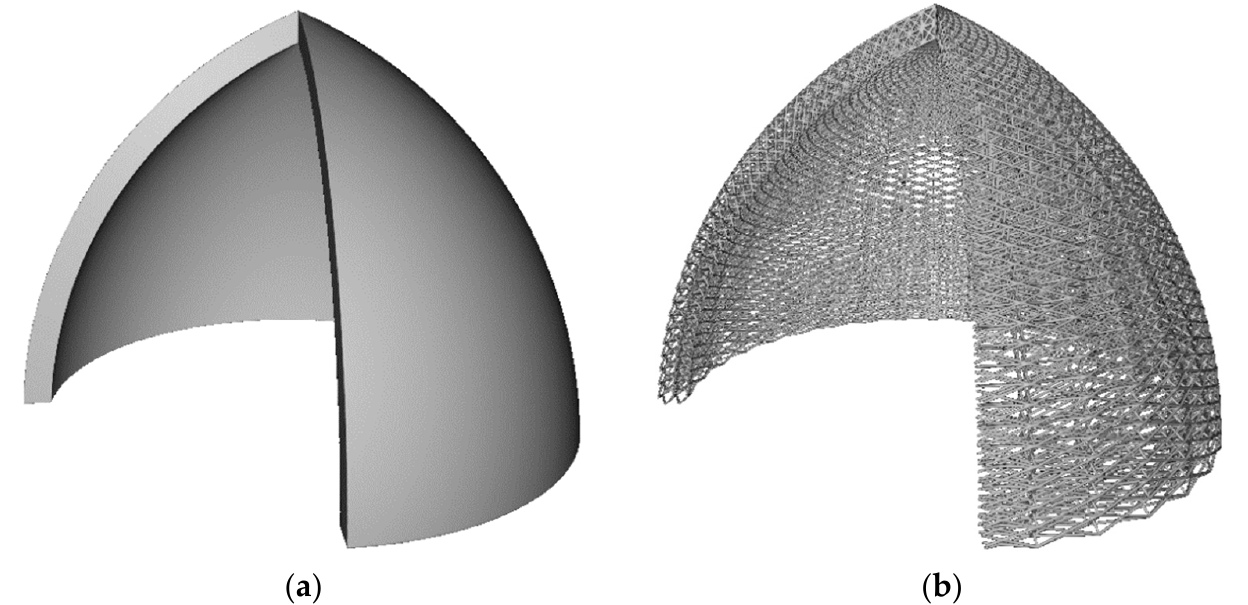
Figure 2. ( a ) Section view of solid dome shape; ( b ) Section view of conformal lattice dome shape.